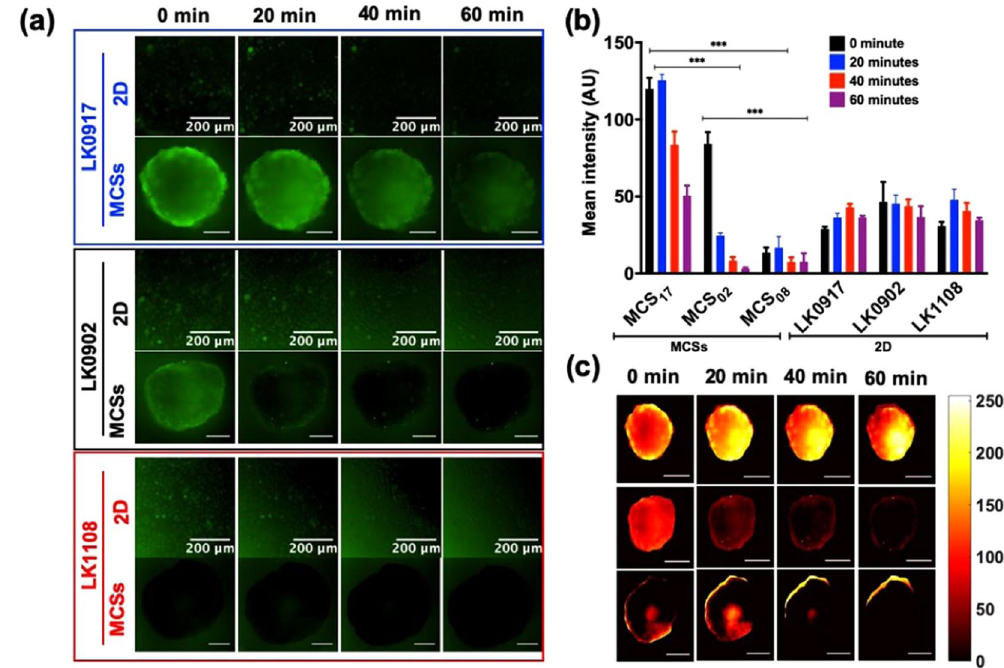
Figure 5. ROS activity of all cell lines in 2D and MCSs. ( a ) Live-cell fluorescence images of the 2D (LK0917, LK0902, and LK1108) and MCSs (MCS 17 , MCS 02 , and MCS 08 ) cultures obtained from cell lines in the presence of DCFDA over a period of 60 minutes with image acquisition at 20-minute intervals (upper, middle and lower panel respectively), scale bar, 200 μ m). ( b ) Redox state in 2D and MCSs cultures. Data are presented as the mean ± SD; *** p < 0.001, ** p < 0.05, * p = 0.019, and no significant differences were observed in case of 2D (n = 3). ( c ) Heat map pseudo color images of MCSs for differential redox status for the three cell lines (scale bar, 200 μ